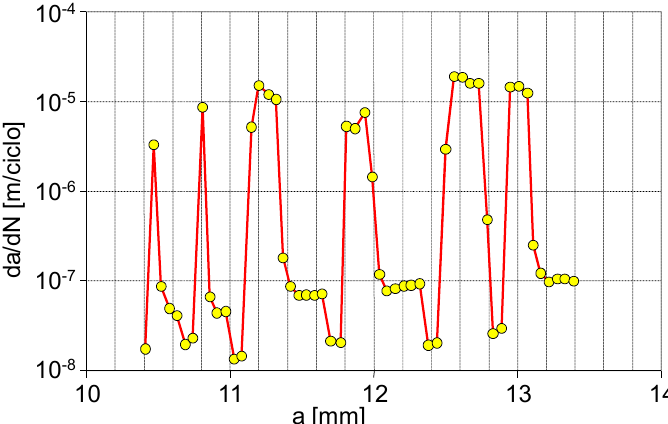
Figura 8: Risultati di prove di propagazione effettuate a intervalli prefissati di crescita di cricca su campioni di acciaio 1.2738 a struttura mista costituita da martensite rinvenuta, bainite ed austenite residua modificate dal rinvenimento. Figure 8: Crack growth rates (da/dN) at fixed crack length intervals (a). 1.2738 steel specimens with a mixed microstructure formed by tempered martensite, as well as bainite and residual austenite modified by tempering.